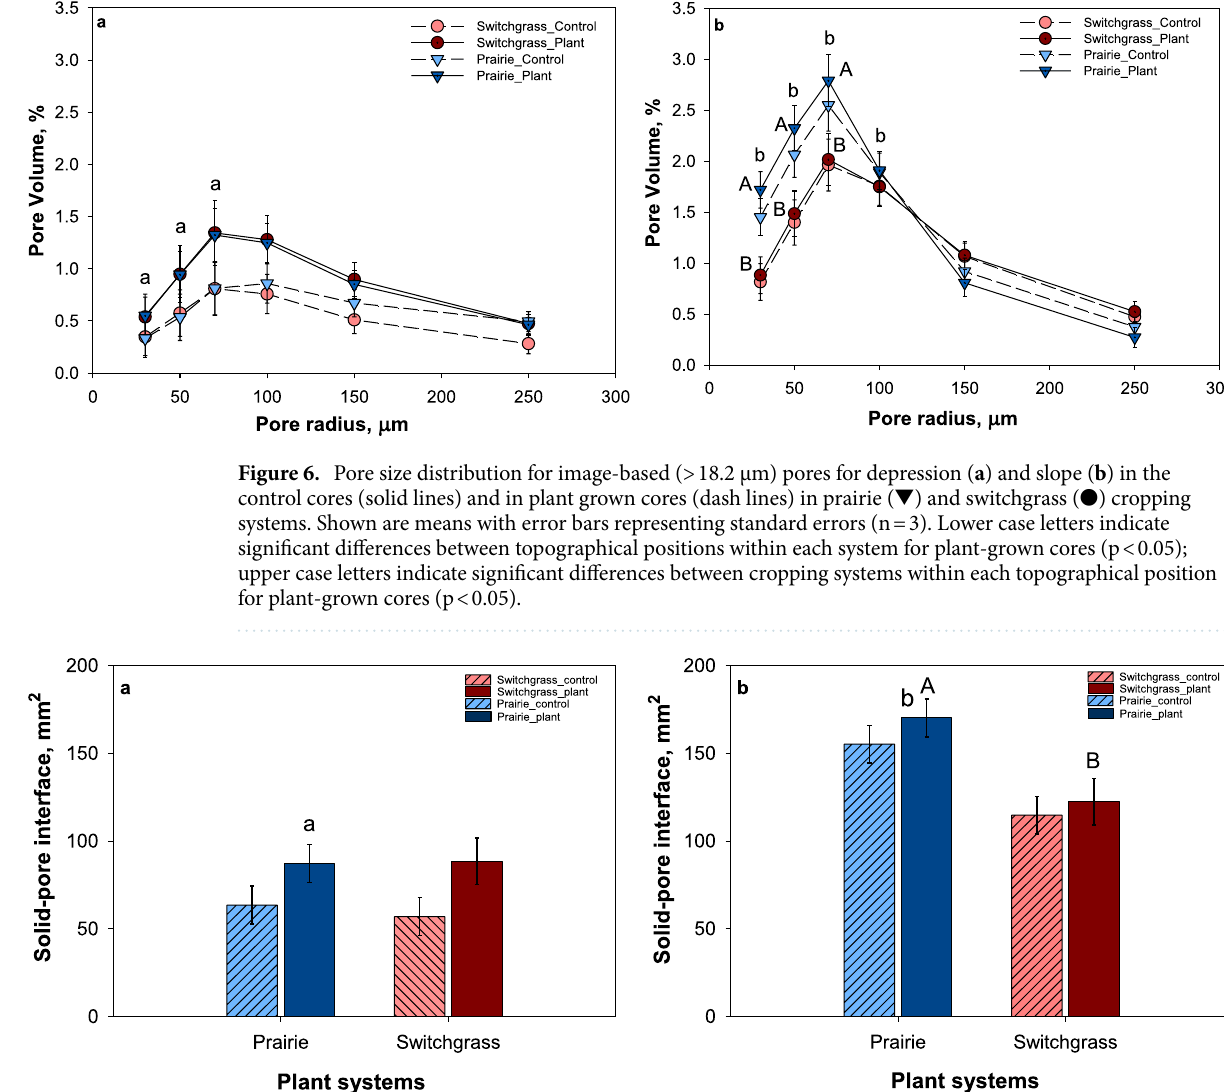
Figure 7. Solid-pore interface (mm 2 ) for depression ( a ) and slope ( b ) in the control cores (dash) and in plant grown cores (solid) in prairie (blue) and switchgrass (red) cropping systems. Shown are means with error bars representing standard errors (n = 3). Lower case letters indicate significant differences between topographical positions within each system for plant-grown cores (p < 0.05); upper case letters indicate significant differences between cropping systems within each topographical position for plant-grown cores (p <